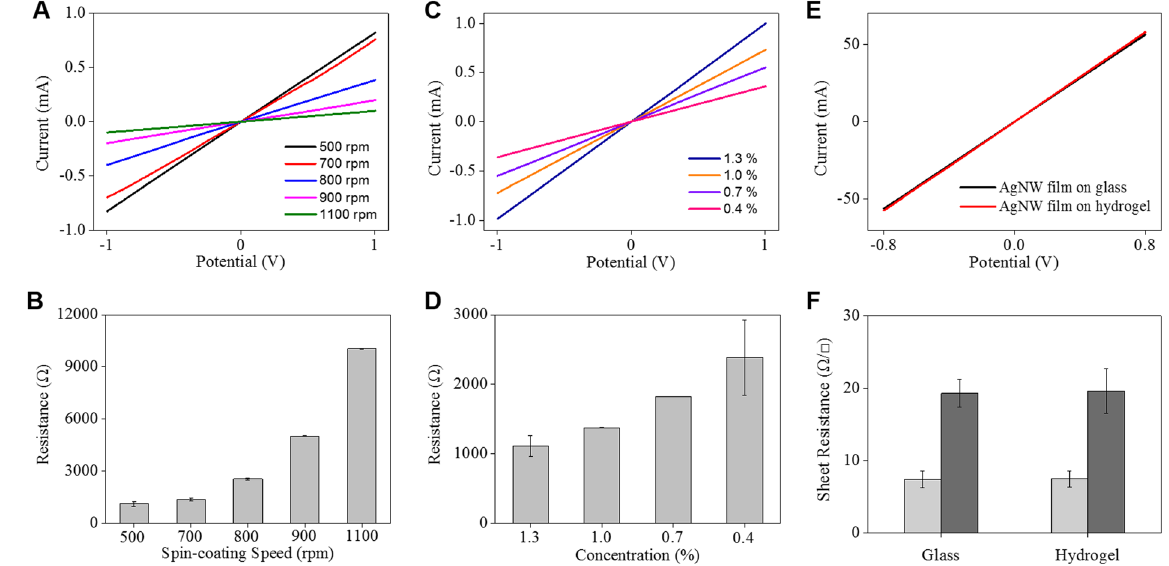
Figure 4. Electrical properties of AgNW-based micropatterns (700 μ m in width and 2 cm in length) was measured by attachment of the copper tape on both sides. ( A ) Current-voltage (I–V) characteristics of AgNW- based micropatterns at the different spin-coating speeds and ( C ) various concentrations of AgNWs dispersion solution. Spin-coating speeds from 500 to 1100 rpm were used to control the thickness of the micropatterns and concentration from 0.4 to 1.3% were used to control the quantity of AgNWs. Resistance of AgNW-based micropatterns on glass substrate as a function of ( B ) spin-coating speeds and ( D ) concentrations. ( E ) Current- voltage (I–V) characteristics of AgNW-based micropatterns on glass before direct transfer, and hydrogel substrate after direct transfer process. ( F ) Sheet resistance of AgNW-based micropatterns on glass and hydrogel with the different spin-coating speeds.